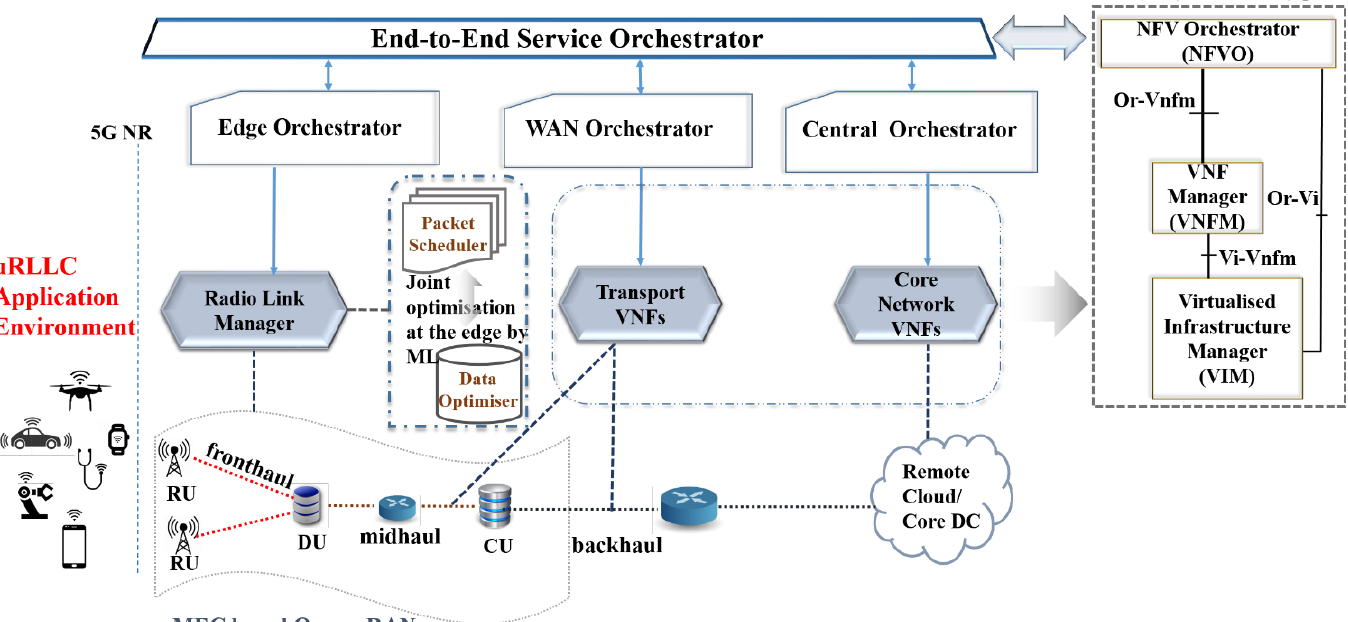
Figure 1. Reference Architecture Framework for Advanced RLM